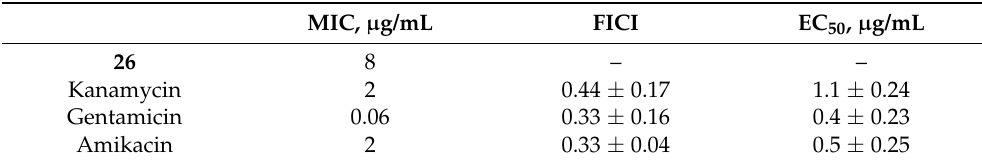
Table 4. Antibacterial activity of aminoglycoside antibiotics in combination with 26 against S. aureus . MIC values indicate inhibitory activity of antimicrobials alone. The median values from five independent experiments are shown. FICI values reflect interaction type of an antibiotic in combination with 26 . EC 50 is an effective concentration of 26 that reduces MIC of the respective antibiotics two-fold; mean ± SD from five calculations is shown.